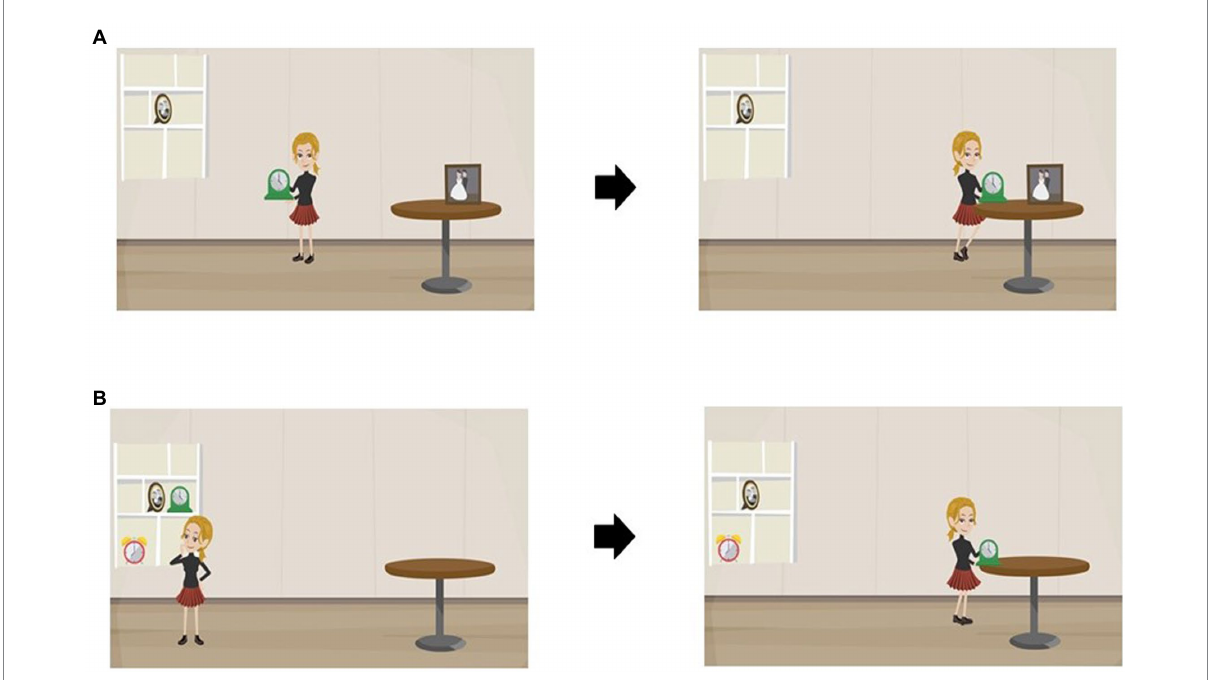
FIGURE 1 Parts of the animations representing two different attachment types for the sentence “Ze zet de klok naast de foto op de tafel” (She puts the clock next to the photo on the table): (A) High-Attachment interpretation. (B) Low-Attachment